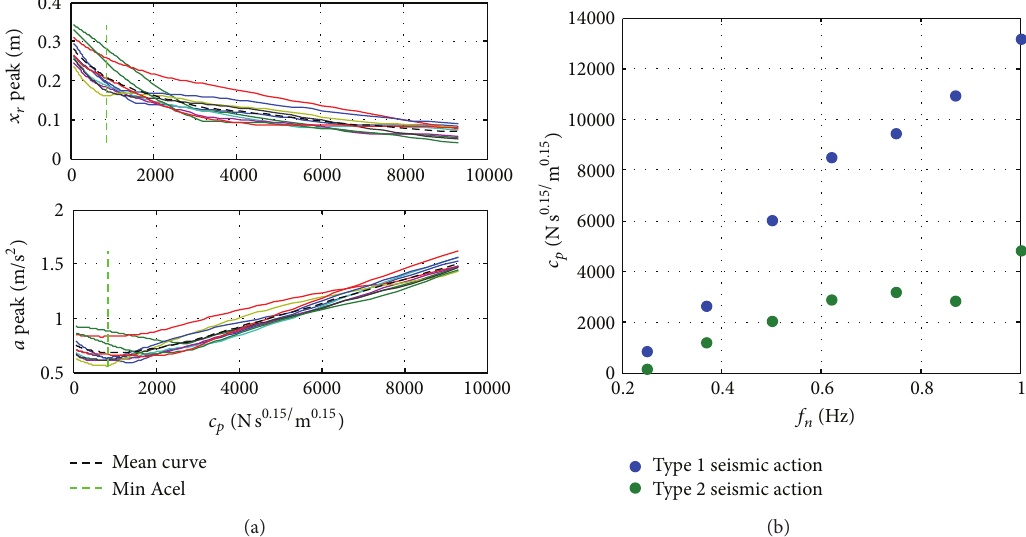
Figure 3: Simulation results for the SDOF model ( 𝑓 𝑛 = 0.25 Hz; 𝜉 = 10 %) with a passive damper. (a) Evolution of responses versus passive device damping for 10 type 1 seismic actions and the correspondent mean curve; (b) damping coefficients (for 𝛼 = 0.15 ) for the minimum mean peak acceleration response function of system natural frequencies under type 1 and 2 seismic actions.